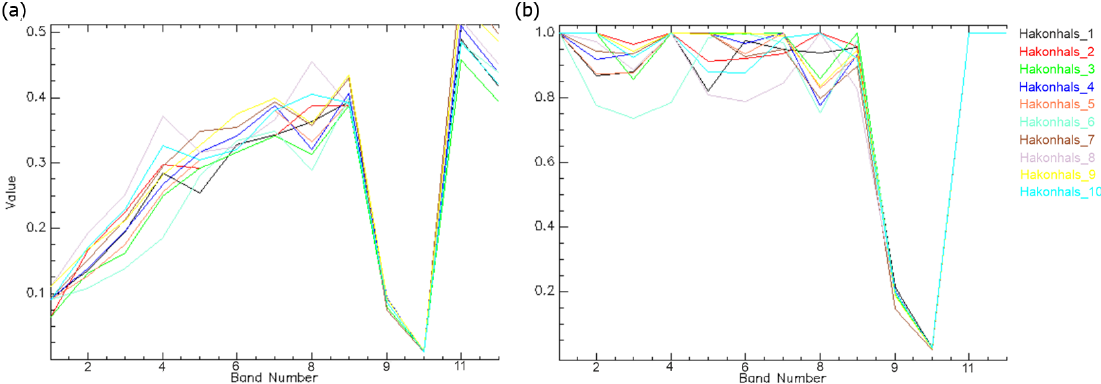
Figure 4. Overall comparison between ( a ) raw and ( b ) continuum-removed spectra of the Håkonhals mine.